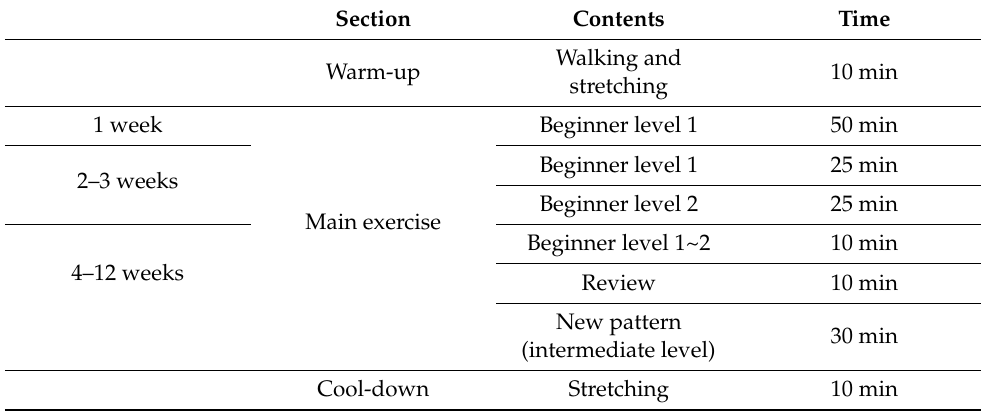
Table 1. Square-stepping exercise implementation method.